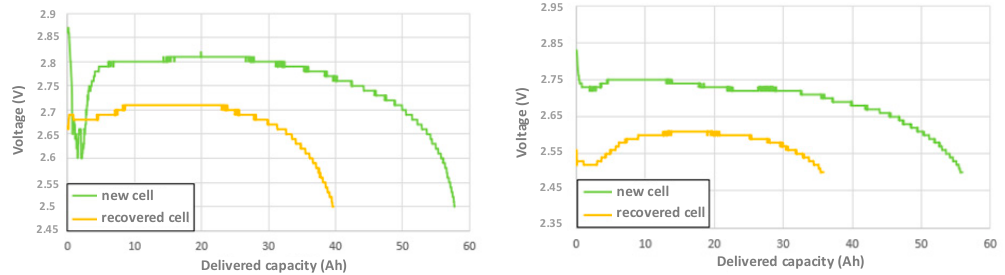
Figure 17. Voltage profile during discharge by 20 A ( left ) and 40 A ( right ) for regenerated (yellow) and referenced cell (green).